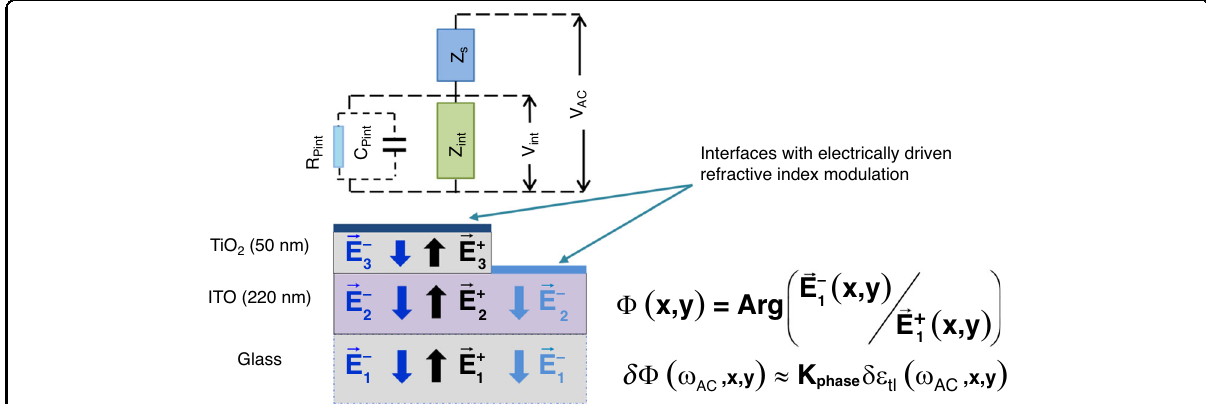
GlassITO Fig. 6 Schematic representation of the equivalent electrical circuit. Phase variation is linearly dependent on the relative permittivity shift, driven by the (local) electric fi eld, of the liquid – sensor